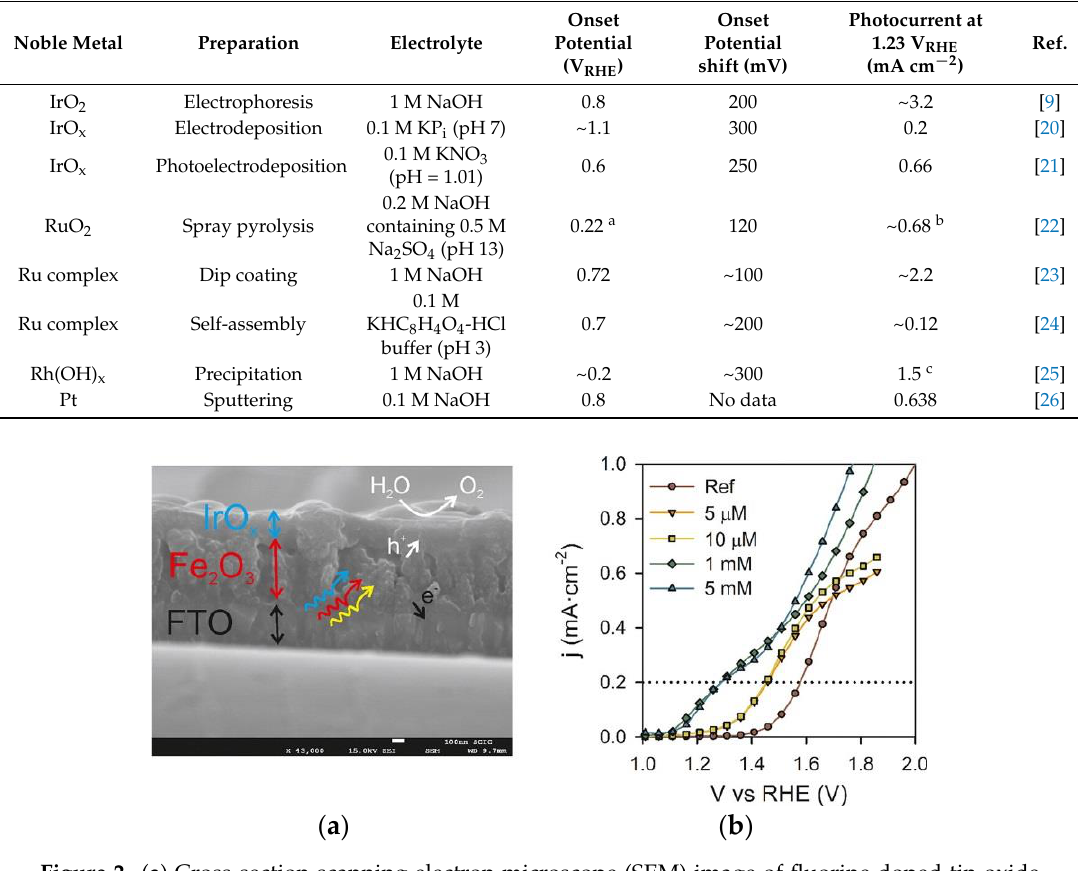
Figure 2. ( a ) Cross-section scanning electron microscope (SEM) image of fluorine doped tin oxide (FTO)/hematite and ( b ) steady-state I-V curves for bare hematite and after electrodeposition of pentamethylcyclopentadienyl (Cp*) iridium(III) [Cp*Ir(III)] from differently concentrated solutions (5 μM, 10 μM, 1 mM and 5 mM). The lines are used as eye guides. Reprinted with permission from Reference [20], copyright (2013) American Chemical Society.